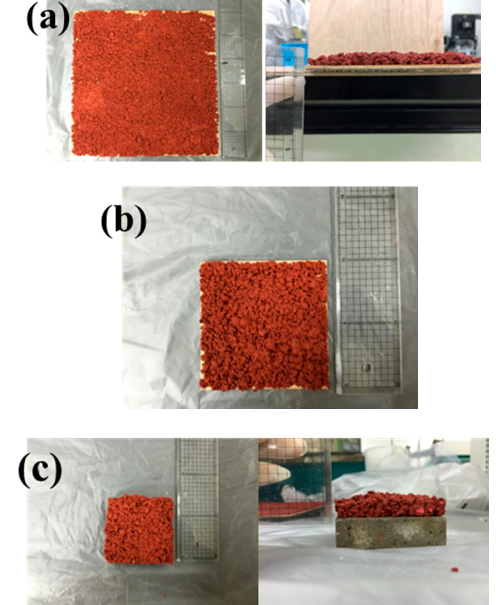
Figure A1. Specimen preparation for ( a ) skid resistance, ( b ) abrasion resistance, and ( c ) bond strength tests.